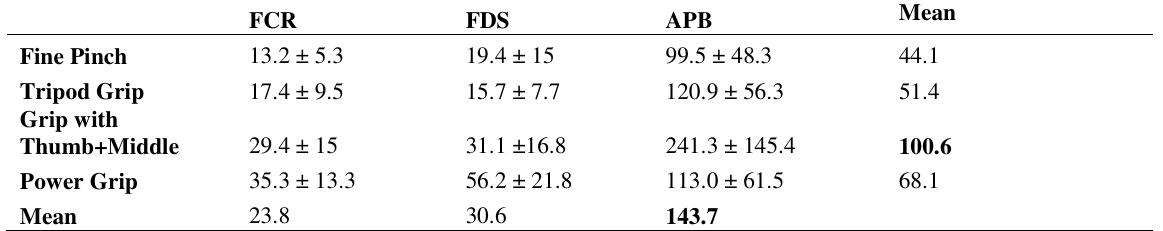
Mean values of EMG activity (mean ± sd) in in ( µ V) of different grips types for the case of 70% MVC for 5 subjects for FCR, FDS and APB